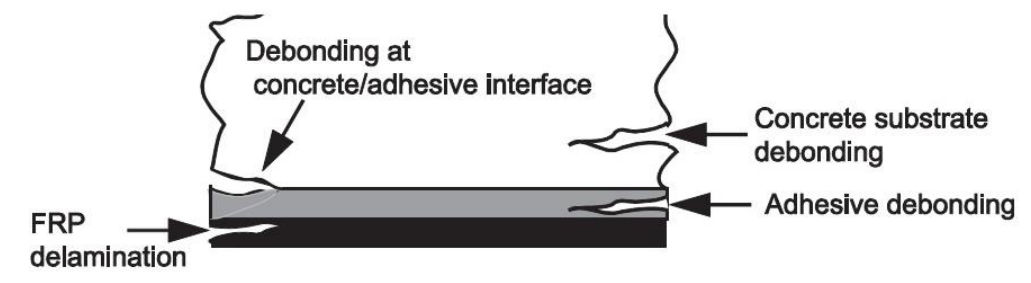
Fig. 1. Different interface crack initiation possible phases